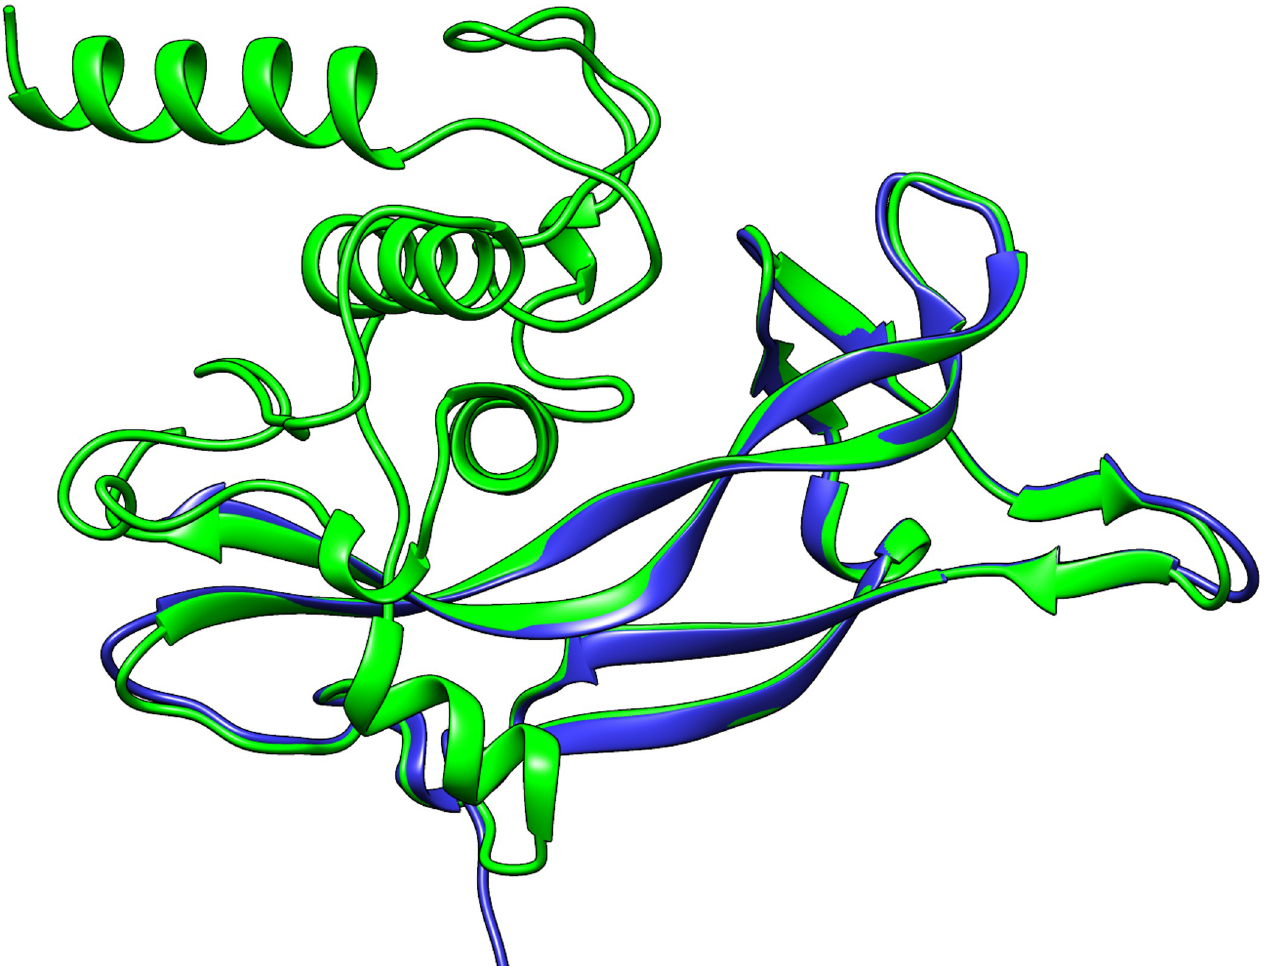
Fig 2. Structural alignment between the theoretical model of BDNF, generated by the Rosetta algorithm, and the experimental fragment of BDNF (PDB ID: 1BND). Cartoon representation of BDNF modeled structure created by Rosetta (green) and the experimental fragment 1BND (blue). The α -helices are represented by ribbons, while the β -strands are represented by